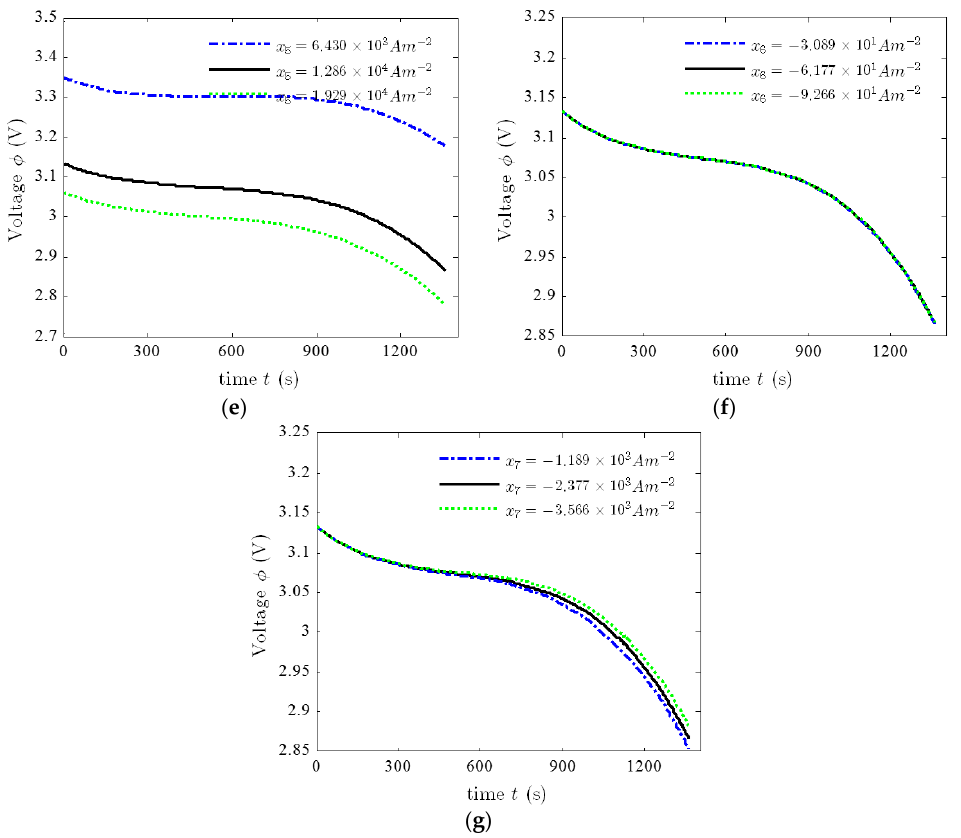
x x x x x x ; ( b ) 2 ; ( c ) 3 ; ( d ) 4 ; ( e ) 5 ; ( f ) 6 and ( g ) 7